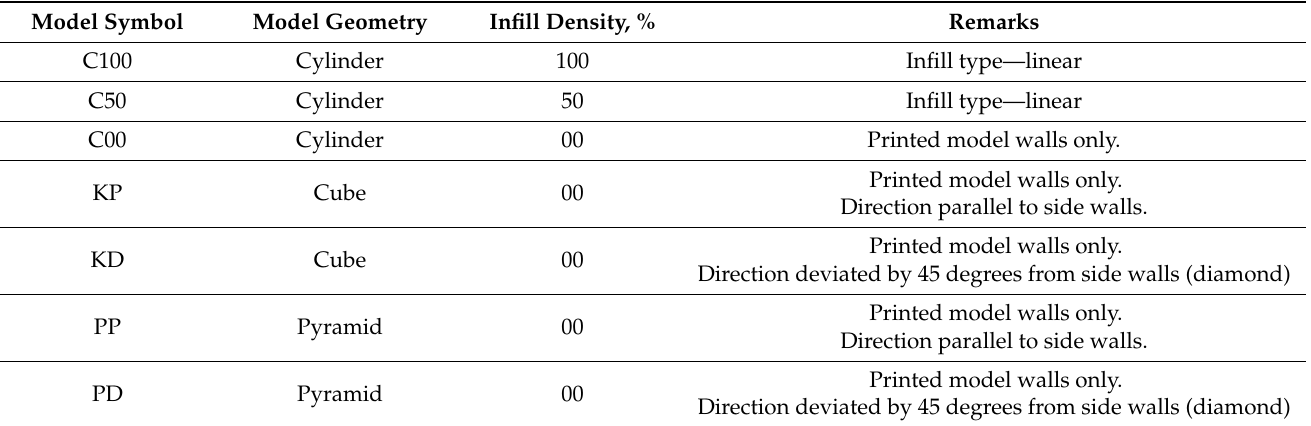
Table 1. Geometry and symbols of printed dampers.